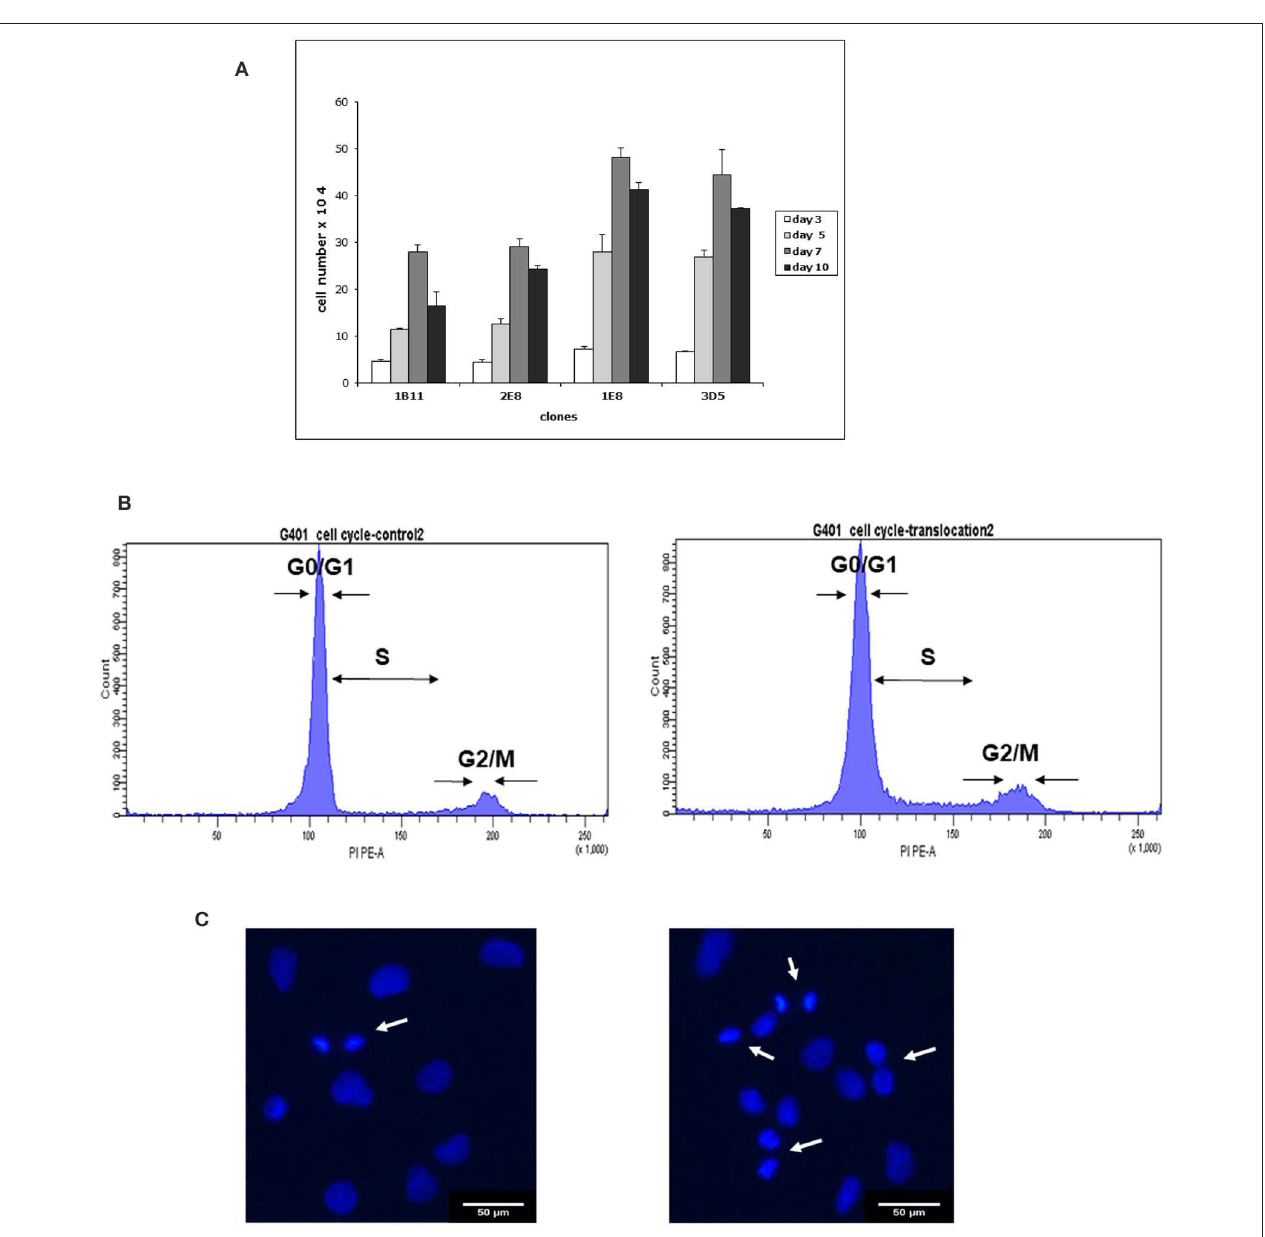
FIGURE 3 | Differences between 2E8 and 3D5 clones in proliferation (A) , cell cycle (B) , and DAPI staining of the nuclei (C) . (A) Proliferation assay: The G-401 cell line has been cloned by limiting dilutions and the cells with partial trisomy 7p were separated from the cells having a normal karyotype. Two clones with normal chromosomes and 2 clones with partial trisomy 7p were used in proliferation experiments. Clones with the partial trisomy 7p (1E8 and 3D5) grew more rapidly than the clones with normal chromosomes (1B11 and 2E8). Cell counts were performed on days 3 (white bars), 5 (light gray bars), 7 (dark gray bars), and day 10 (black bars). The percentage of dead cells in cultures did not exceed 10%. Values are cell number means ± SEM of three independent sets of experiments with n = 9. (B) Cell cycle analysis: Asynchronously dividing cells were stained with PI and measured on FACSAria. Linear gates were set on PI fluorescence distribution histogram to mark G0/G1, S, and G2/M phases of the cell cycle. Cell frequencies in each phase are provided as mean ± SD ( n = 3). Representative histograms for 2E8 and 3D5 clones are shown. In 2E8 clone (left side) the G0/G1 comprised 85.33 ± 1.31%, S comprised 6.6 ± 1.49% and G2/M comprised 5.9 ± 0.82% cells. In 3D5 clone (right side) G0/G1 phase comprised 75.33 ± 4.25%, S comprised 14.97 ± 0.93%, and G2/M comprised 8.03 ± 3.76%. (C) DAPI staining for identification of mitotic cells: Asynchronous cultures of 2E8 and 3D5 cells were used for DAPI staining of the nuclei. Mitotic cells are indicated with an arrow. Scale bar 50 µ M. 2E8 cells (46, XY) (on left side) and 3D5 cells (46,XY,der(12)t(7;12) (on right side) were digitally imaged on an Olympus microscope. Mitotic cells are recognized by the bright DAPI staining of their condensed chromatin.